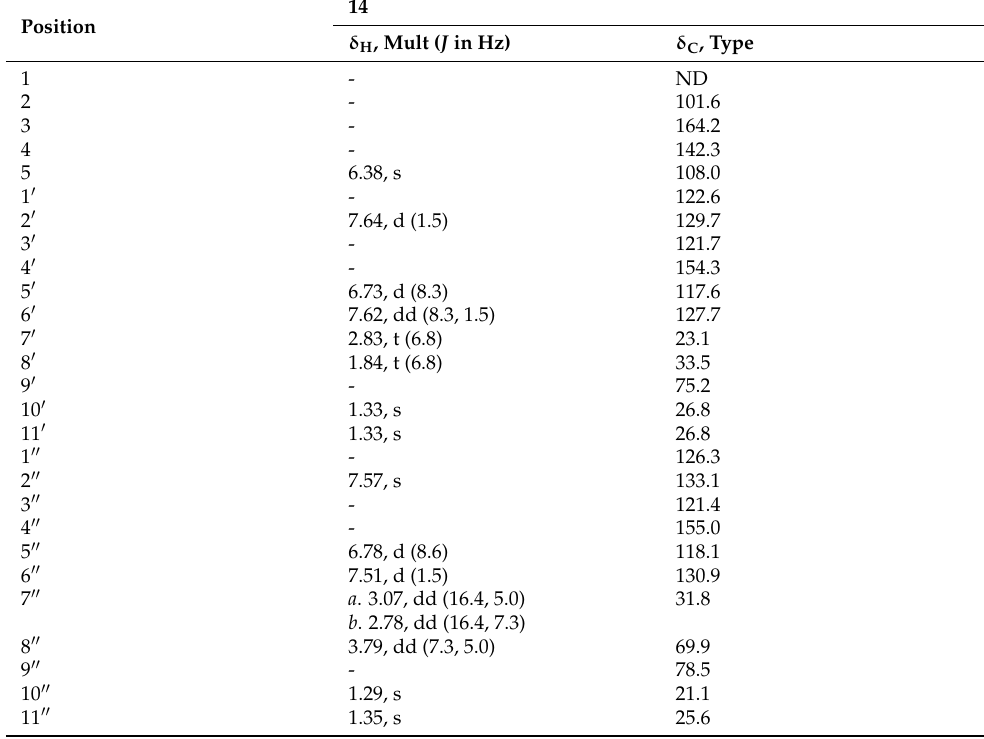
Figure 10. Isomeric substructures featuring a substituted ( a ) dihydrobenzofuran, ( b ) dihydroben- zopyran, and ( c ) epoxide. Highlight (blue) indicated key oxygenated residues.